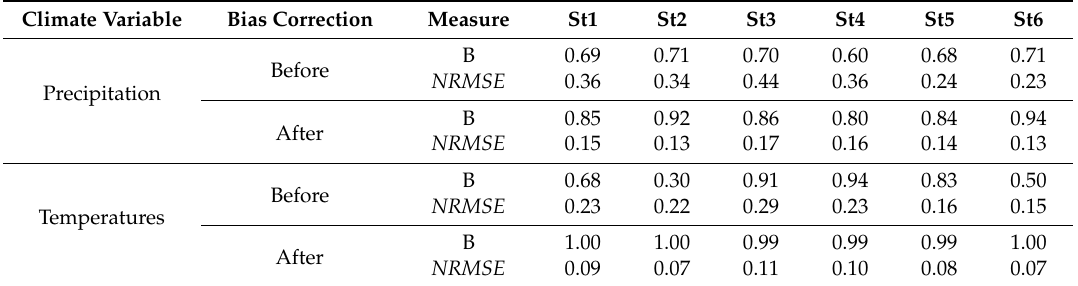
Table 4. Effects of bias-correction of precipitation and temperatures based on B and NRMSE indices before and after application of the ISI-MIP